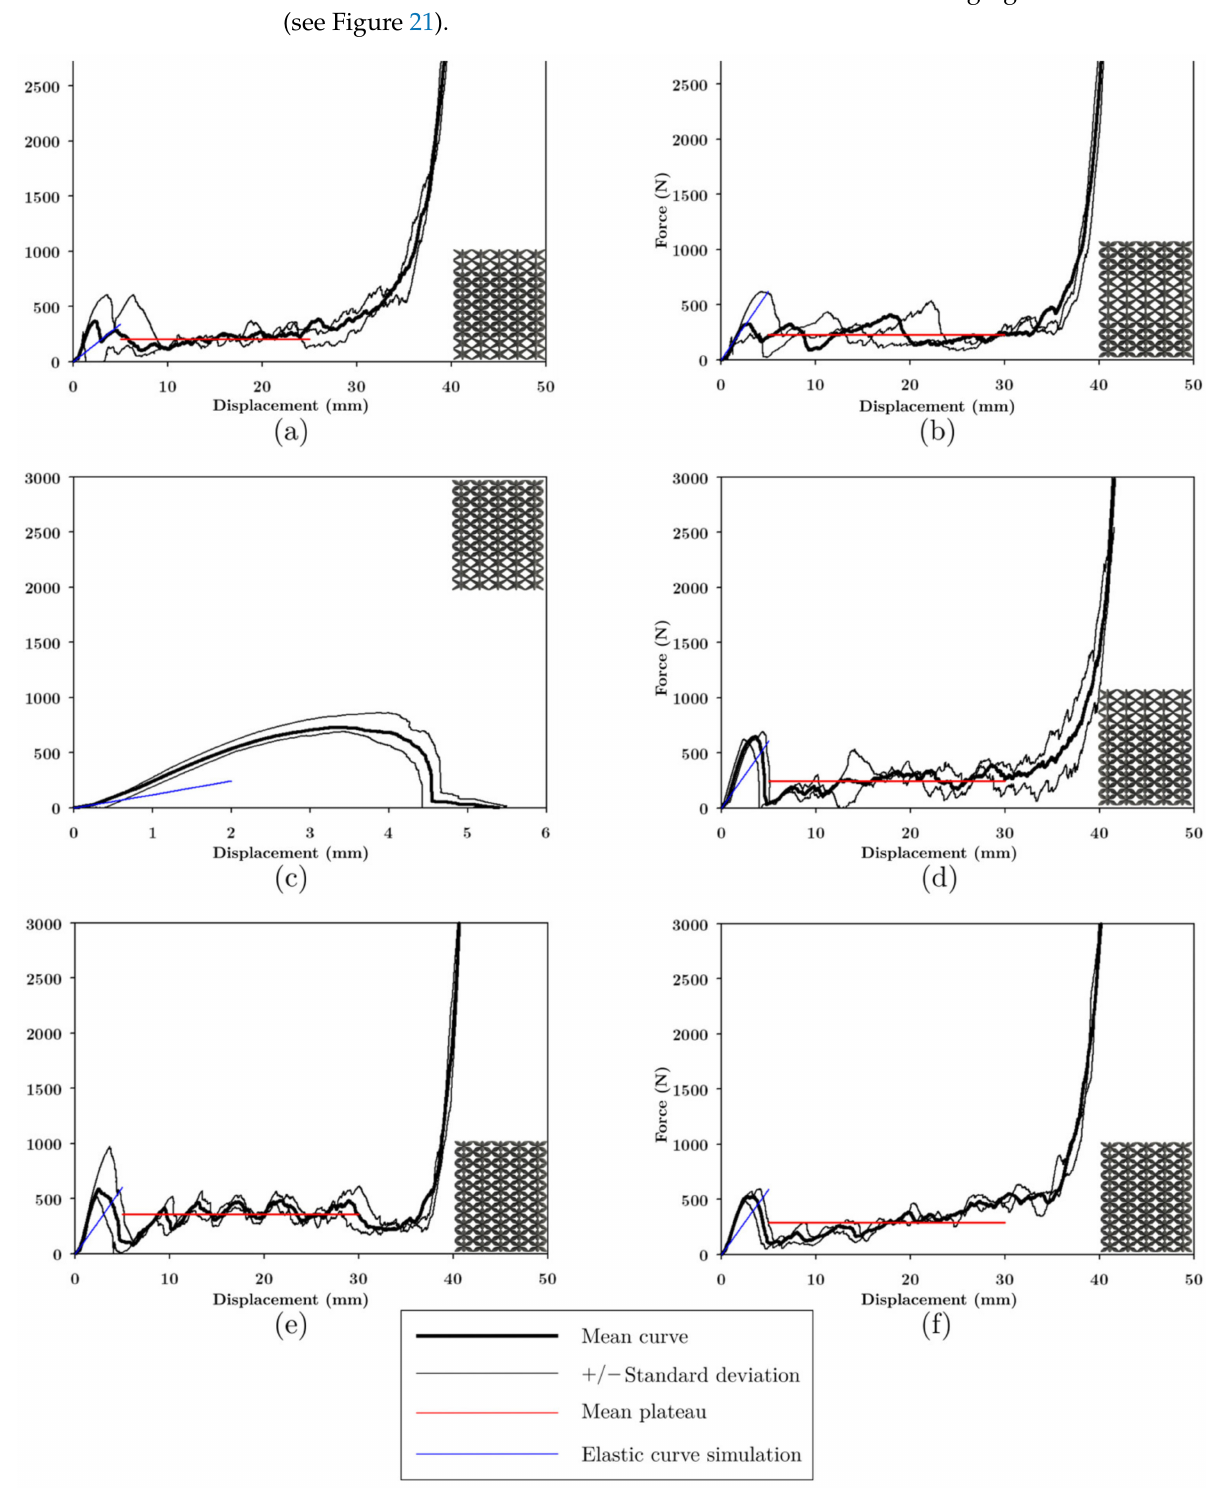
Figure 22. Force-displacement curve of LLS manufactured with resin: ( a ) HM-LM-HM, ( b ) LM-HM-LM, ( c ) HM-IM-LM, ( d ) LM-IM-HM, ( e ) LM-IM-LM, and ( f )